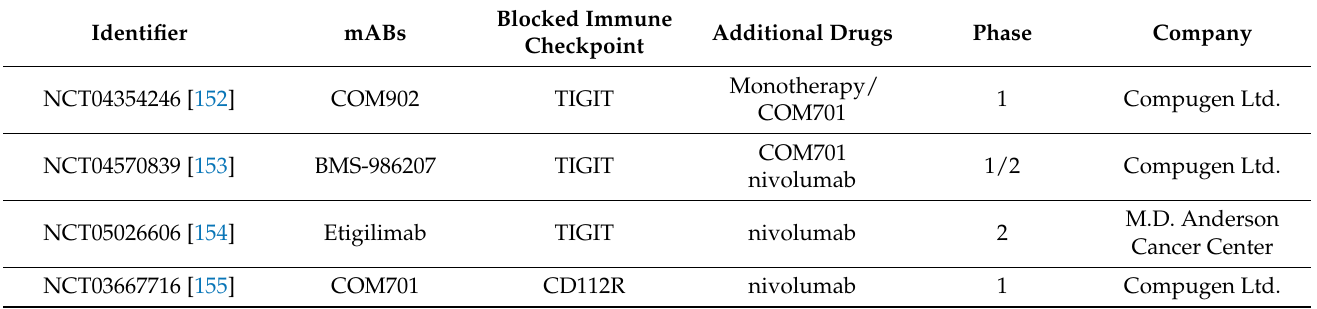
Table 2. Ongoing clinical trials based on the TIGIT/CD155/DNAM-1 pathway in OC